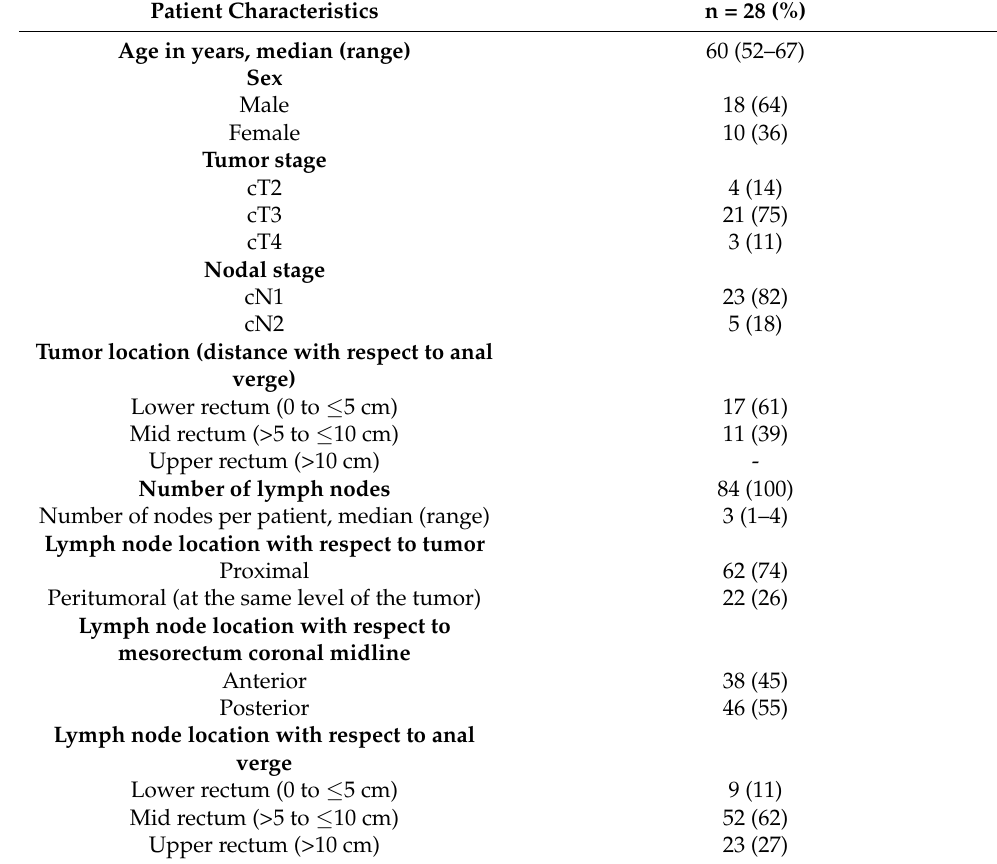
Table 1. Patient characteristics. Data are displayed as numbers (%) unless indicated